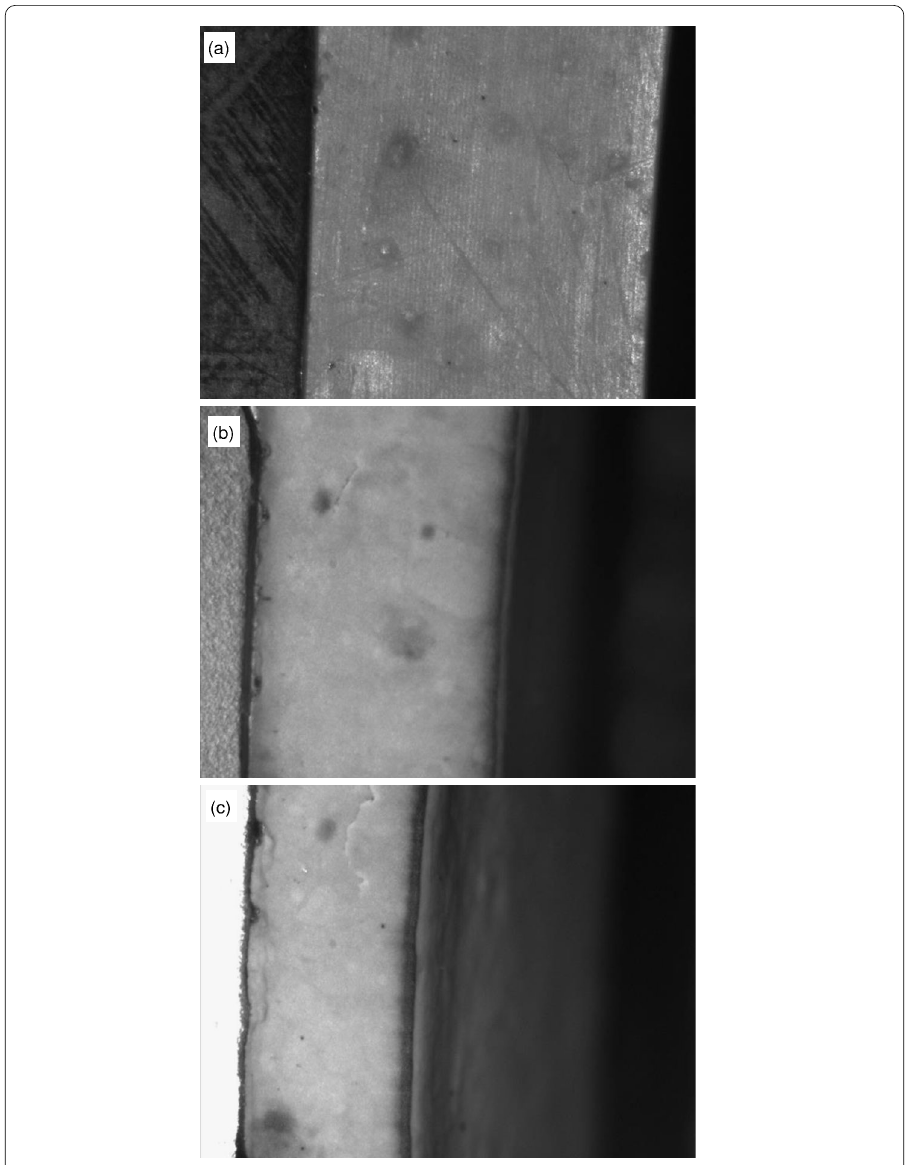
Figure 16 Telemicroscope images of the top face of a channel wall of the SPT-100D at different operation times: before test ( a ), after about 137 hours ( b ), and after about 300 hours of operation ( c